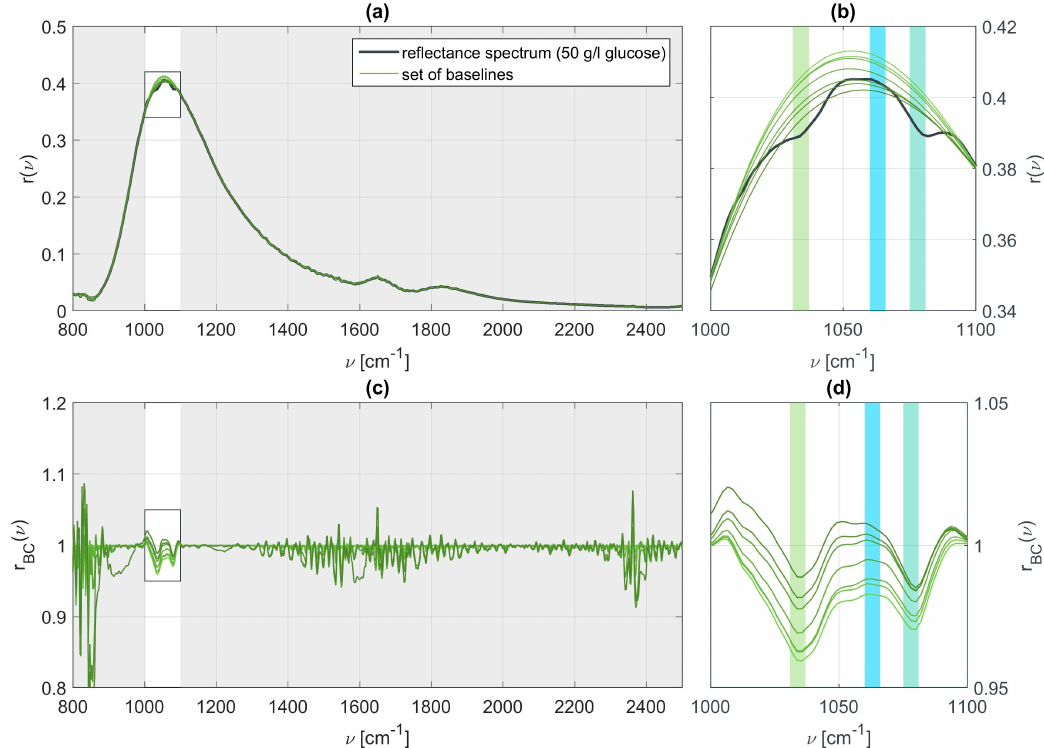
Figure 4. ( a ) Relative reflectance measured for 50 g/l aqueous glucose together with a set of baselines for varying parameters λ ; ( b ) Zoom in on the relevant range of wavenumbers at which vibrational resonances are expected to appear for glucose and fructose; ( c , d ) Baseline corrected signals and the influence of λ on the vibrational features.